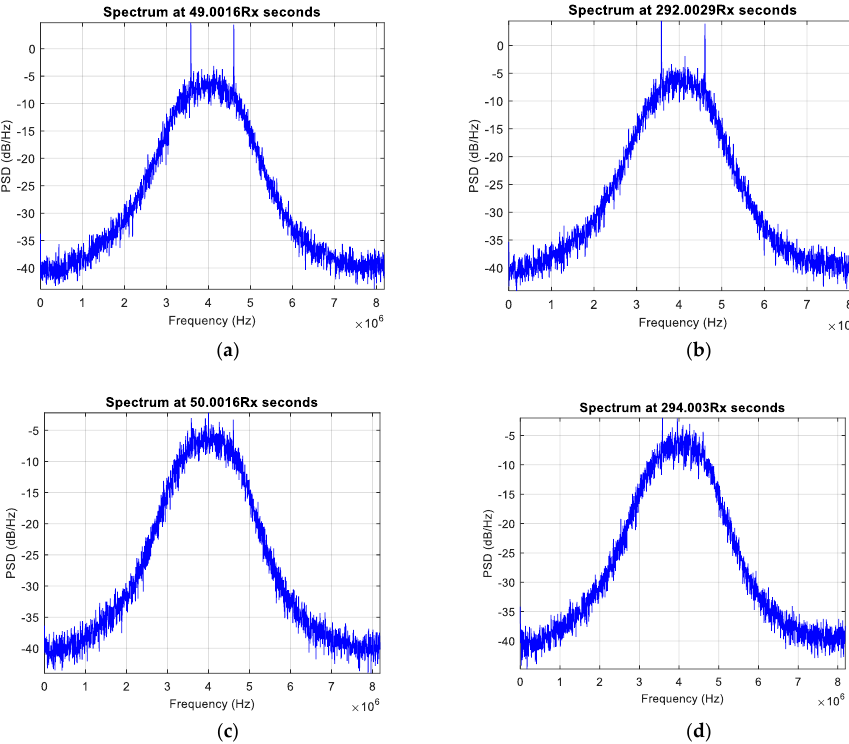
Figure 12. The PSD observed in the afternoon of 19th May 2017: in open sky ( a , b ) and when the Western part of the sky was obscured by buildings ( c , d ).